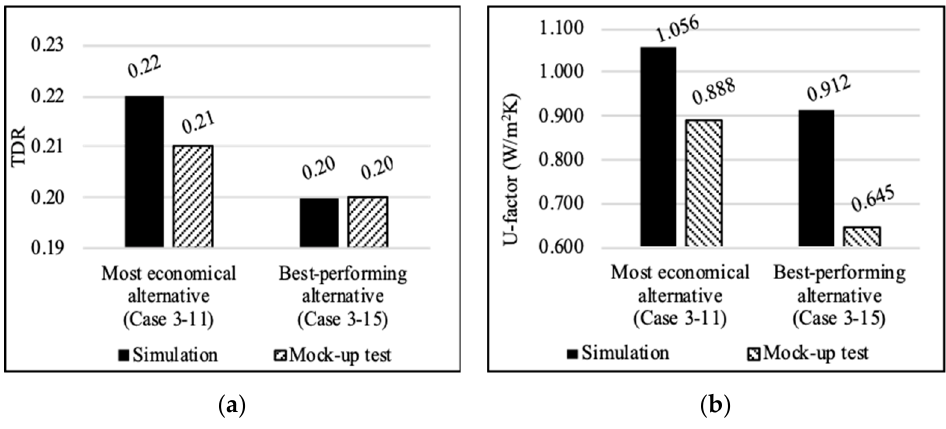
Figure 12. Mock-up test results compared with the simulation results: ( a ) TDR ; ( b ) U-factor.